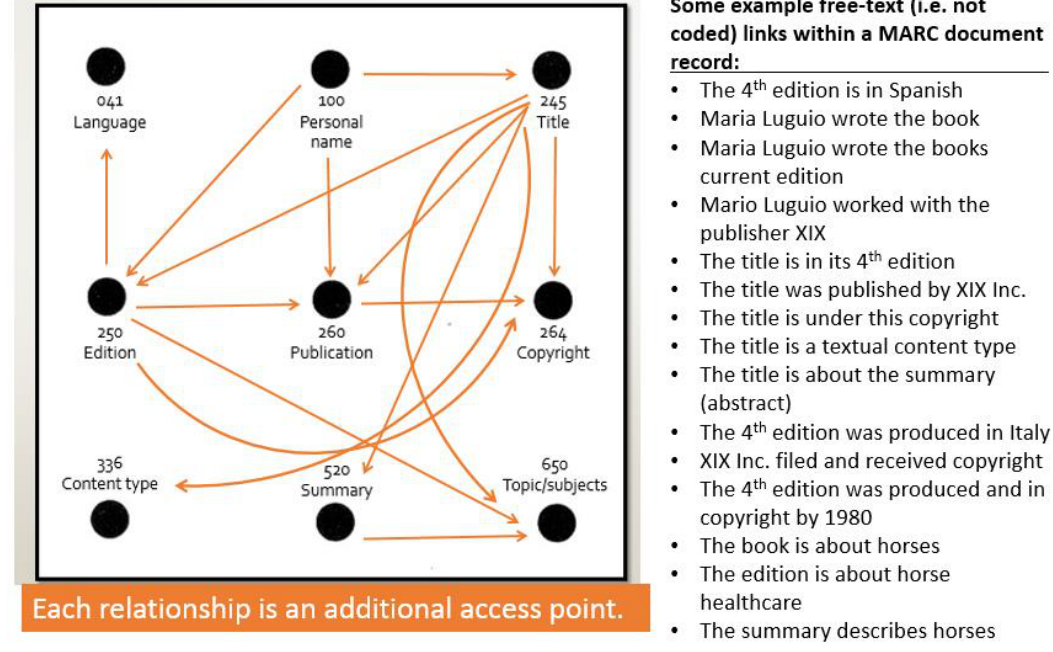
Example Library Knowledge Graph Using Linked